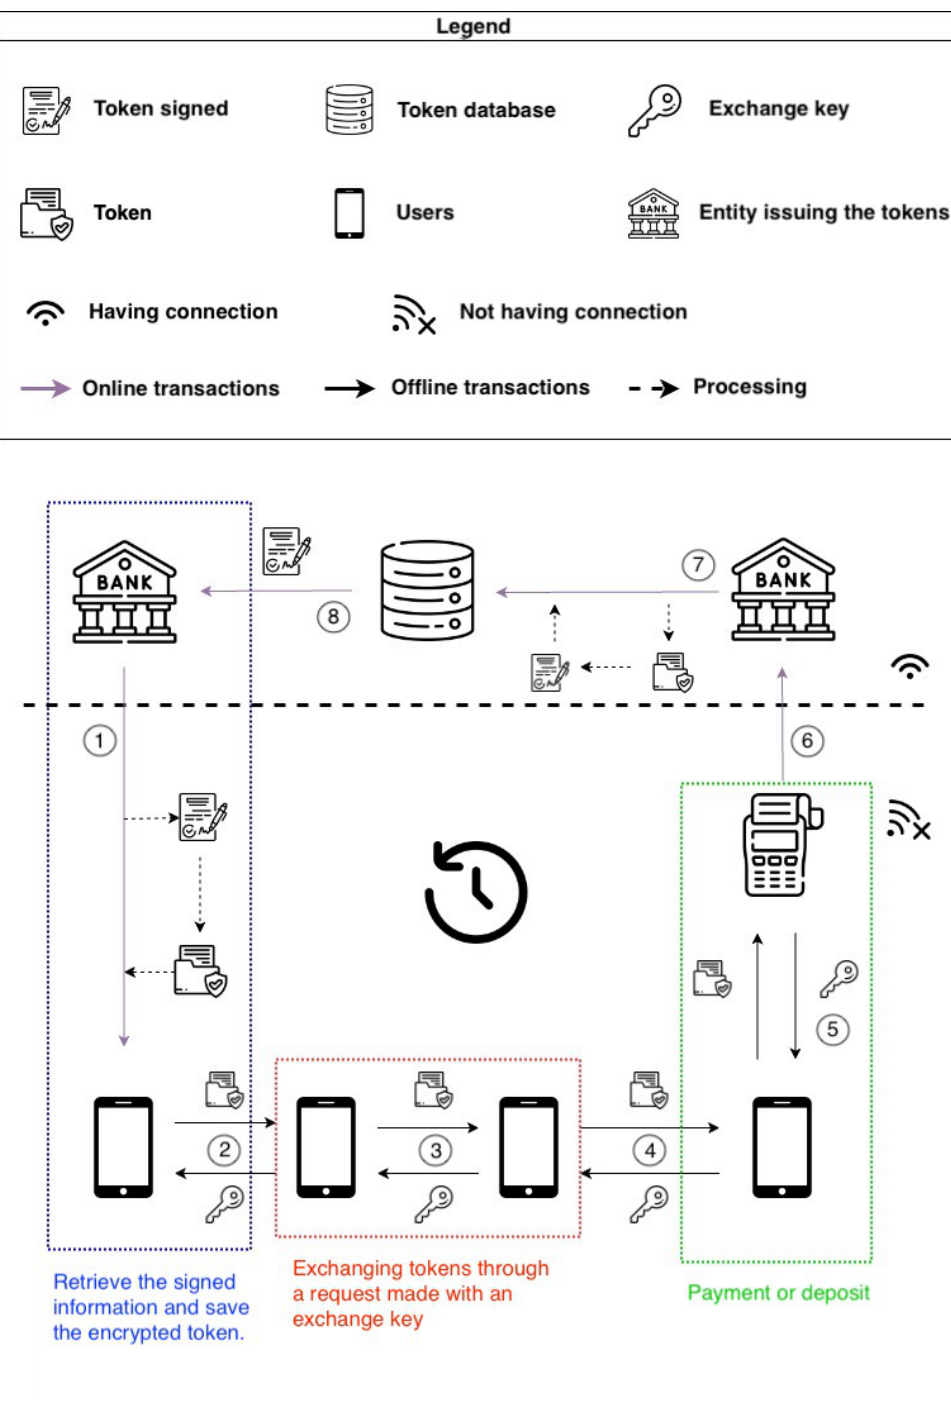
Figure 6. Life cycle of a transaction using an asymmetric